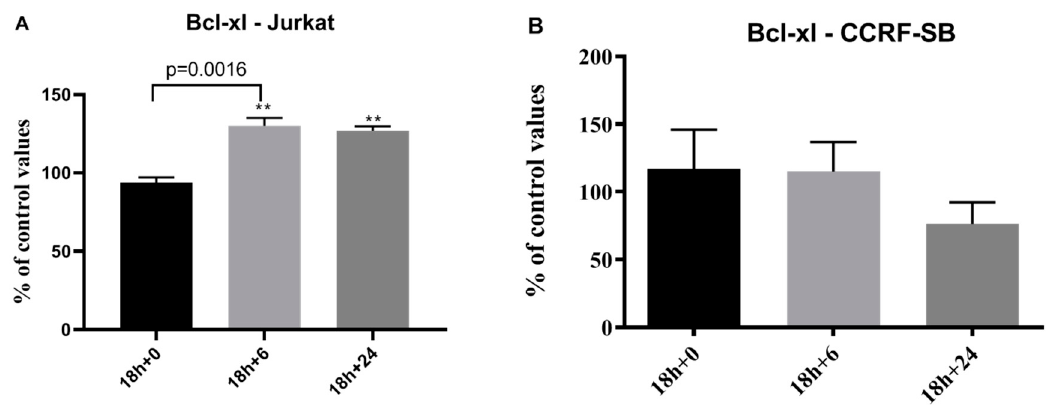
Figure 6. Evolution of Bcl-xl in JURKAT ( A ) and CCRF-SB ( B ) cells after 18 hours of hyperoxic exposure as compared to normoxia, **= p < 0.01 from the baseline.